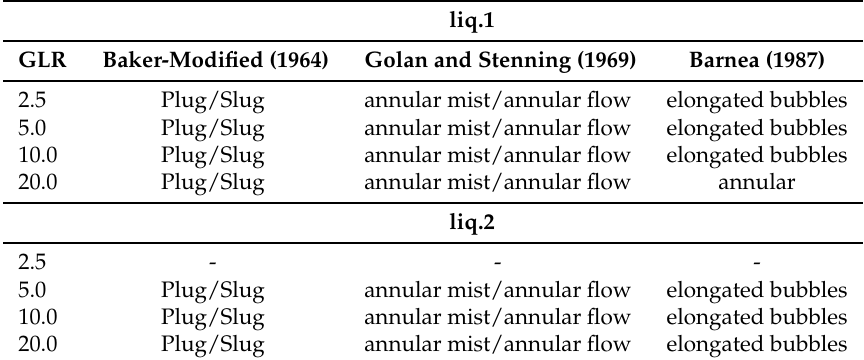
Table 7. Estimation of the OIG atomizer internal flows by different two-phase flow maps at GLR = 2.5%.